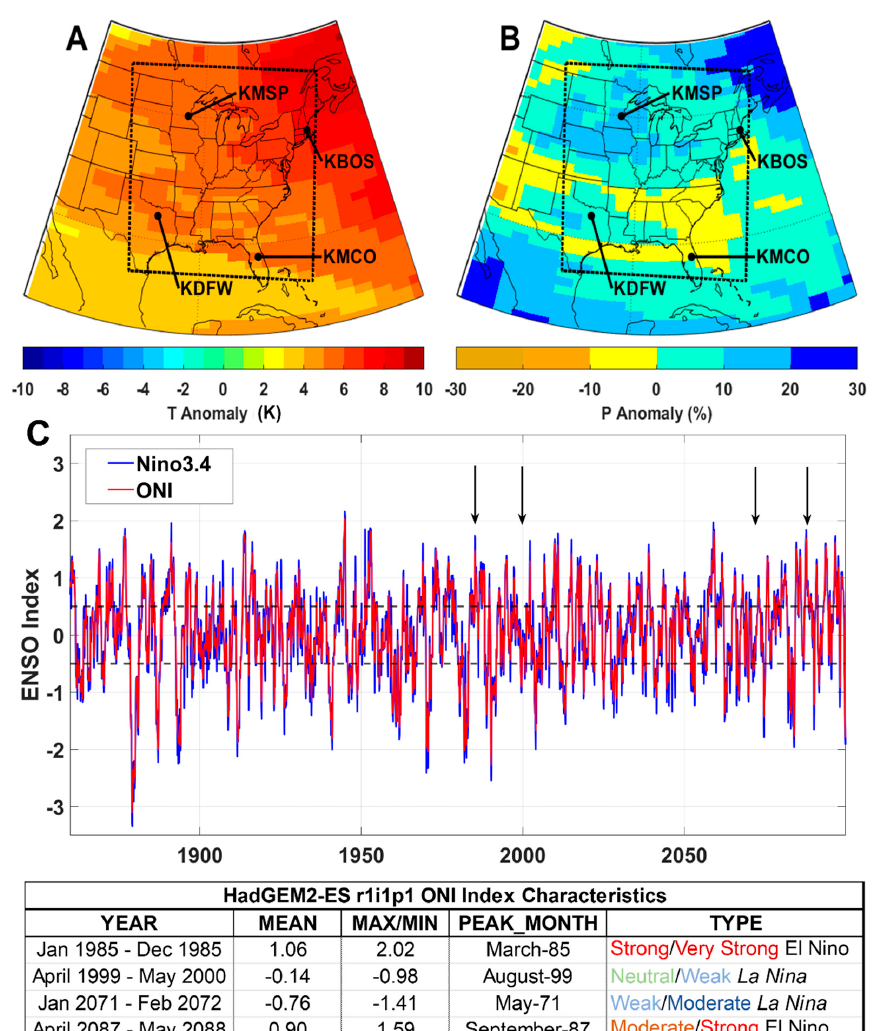
Figure 1. ( A ) Domains used in the WRF simulations. The outer domain comprises 320 × 320 cells at a 12 km grid spacing, while domain 2 (denoted by dashed line) comprises 676 × 676 cells at a 4 km grid spacing. The cities for which specific analyses were performed are denoted by their National Weather Service station code. Also shown is the mean temperature (T) anomaly (in Kelvin) from HadGEM2 for 2070–2099 (RCP8.5) compared to the baseline period (1970–1999). ( B ) The same as for ( A ), but with the mean precipitation (P) anomalies (as a %) from HadGEM2. ( C ) ENSO index timeseries derived from monthly SST data in HadGEM2 for the Niño3 (5–5° N, 90–150° W) and Niño3.4 (5–5° N, 120–170° W) regions. The table summarizes the Niño3 ENSO characteristics for all months within the simulation periods shown in the YEAR column, including the mean index, the relative maximum or minimum index (max for El Niño, min for La Niña), the month when the maximum or minimum occurs for each period, and the characterization of the ENSO type during each period. The arrows over the timeseries indicate the events that form the focus of this analysis (arrows from left to right match the rows in the table from top to bottom).